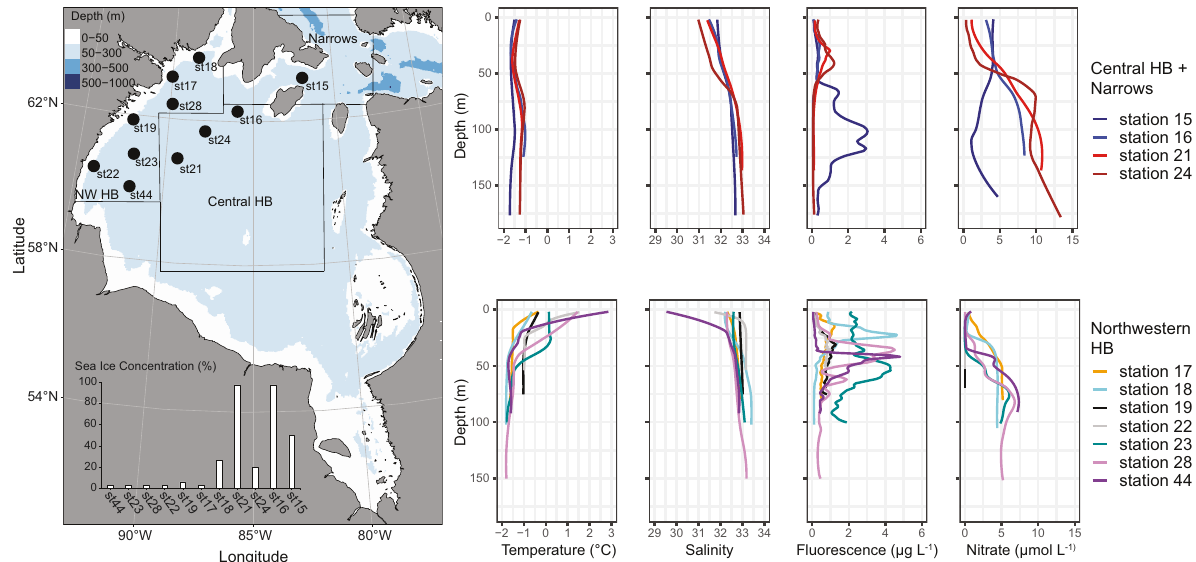
Fig. 1 Water sampling sites and water column properties in the Hudson Bay. Left panel shows the sampling locations with sea ice concentrations. Right panel indicates vertical CTD pro fi les for temperature, salinity, Chl fl uorescence and nitrate concentration down the water